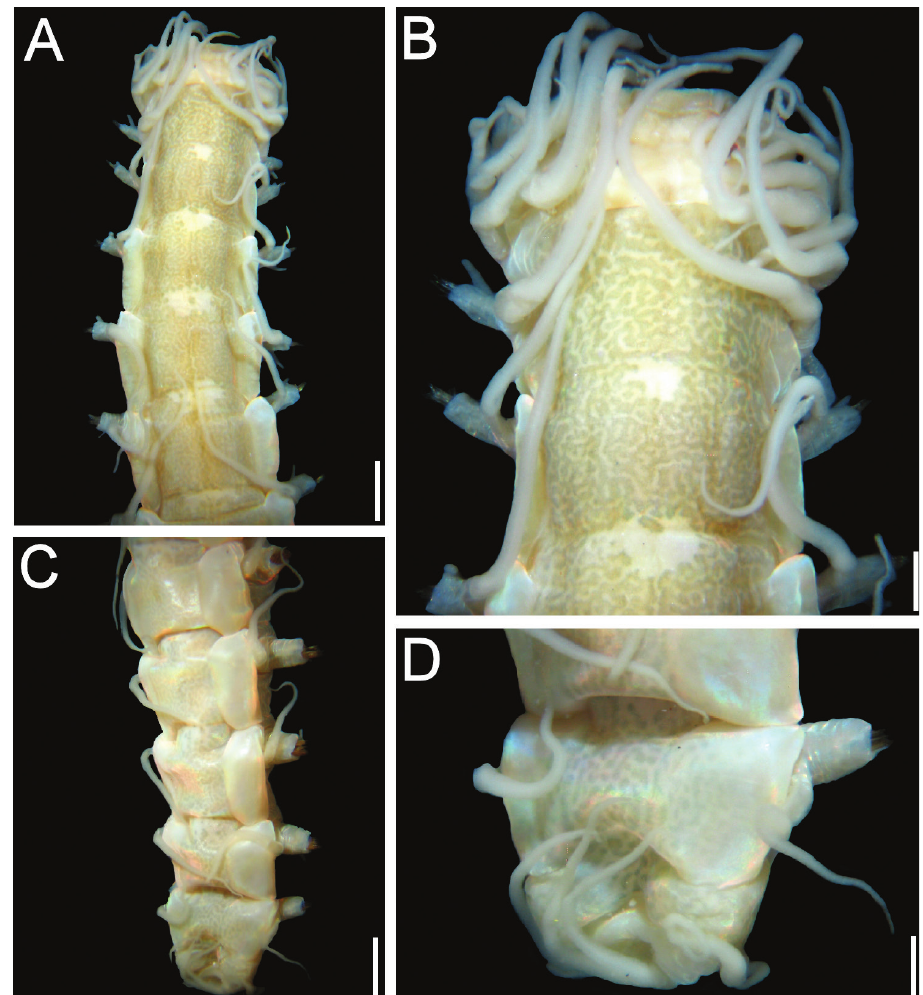
Figure 1. Elisesione mezianei sp. n. Holotype (MNHN 1777). A Anterior region, dorsal view B Anterior end, dorsal view C Posterior region, slightly oblique dorsal view D Pygidium. Scale bars A 1.6 mm, B 0.5 mm, C 1.2 mm, D 0.4